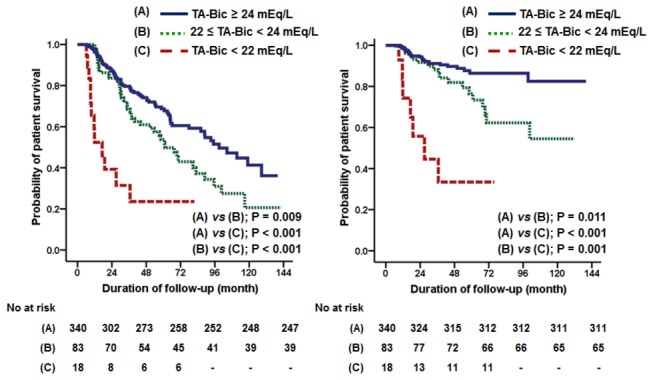
Kaplan-Meier plots for all-cause (right) and cardiovascular (left) mortality based on the level of time-averaged serum bicarbonate (TA-Bic).